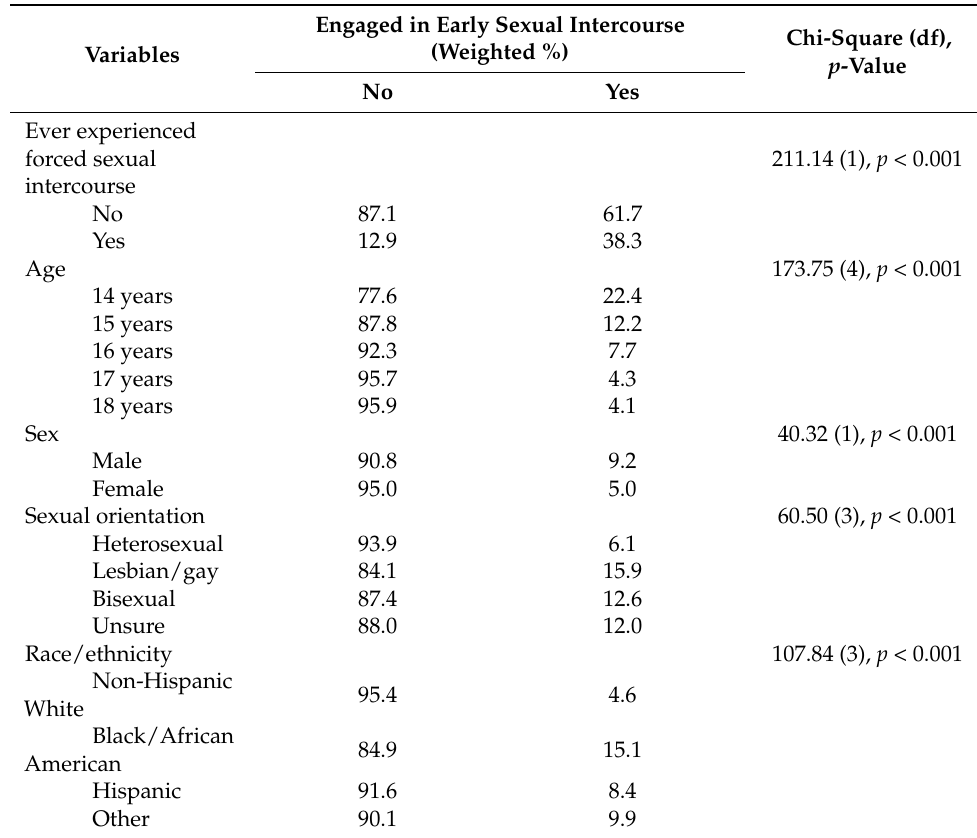
Table 2. Bivariate association between demographic factors and early sexual intercourse among adolescents aged 14–18 who had ever had sex ( n = 6252).